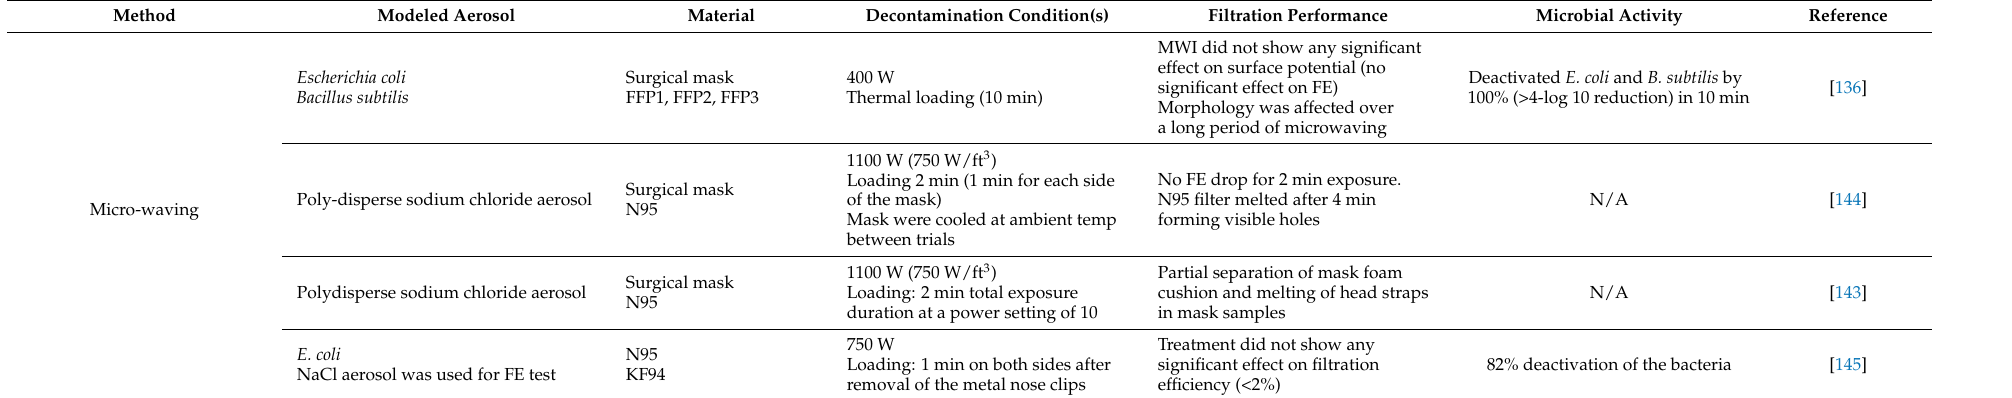
Table 11. Decontamination and regeneration using microwave irradiation (MWI).